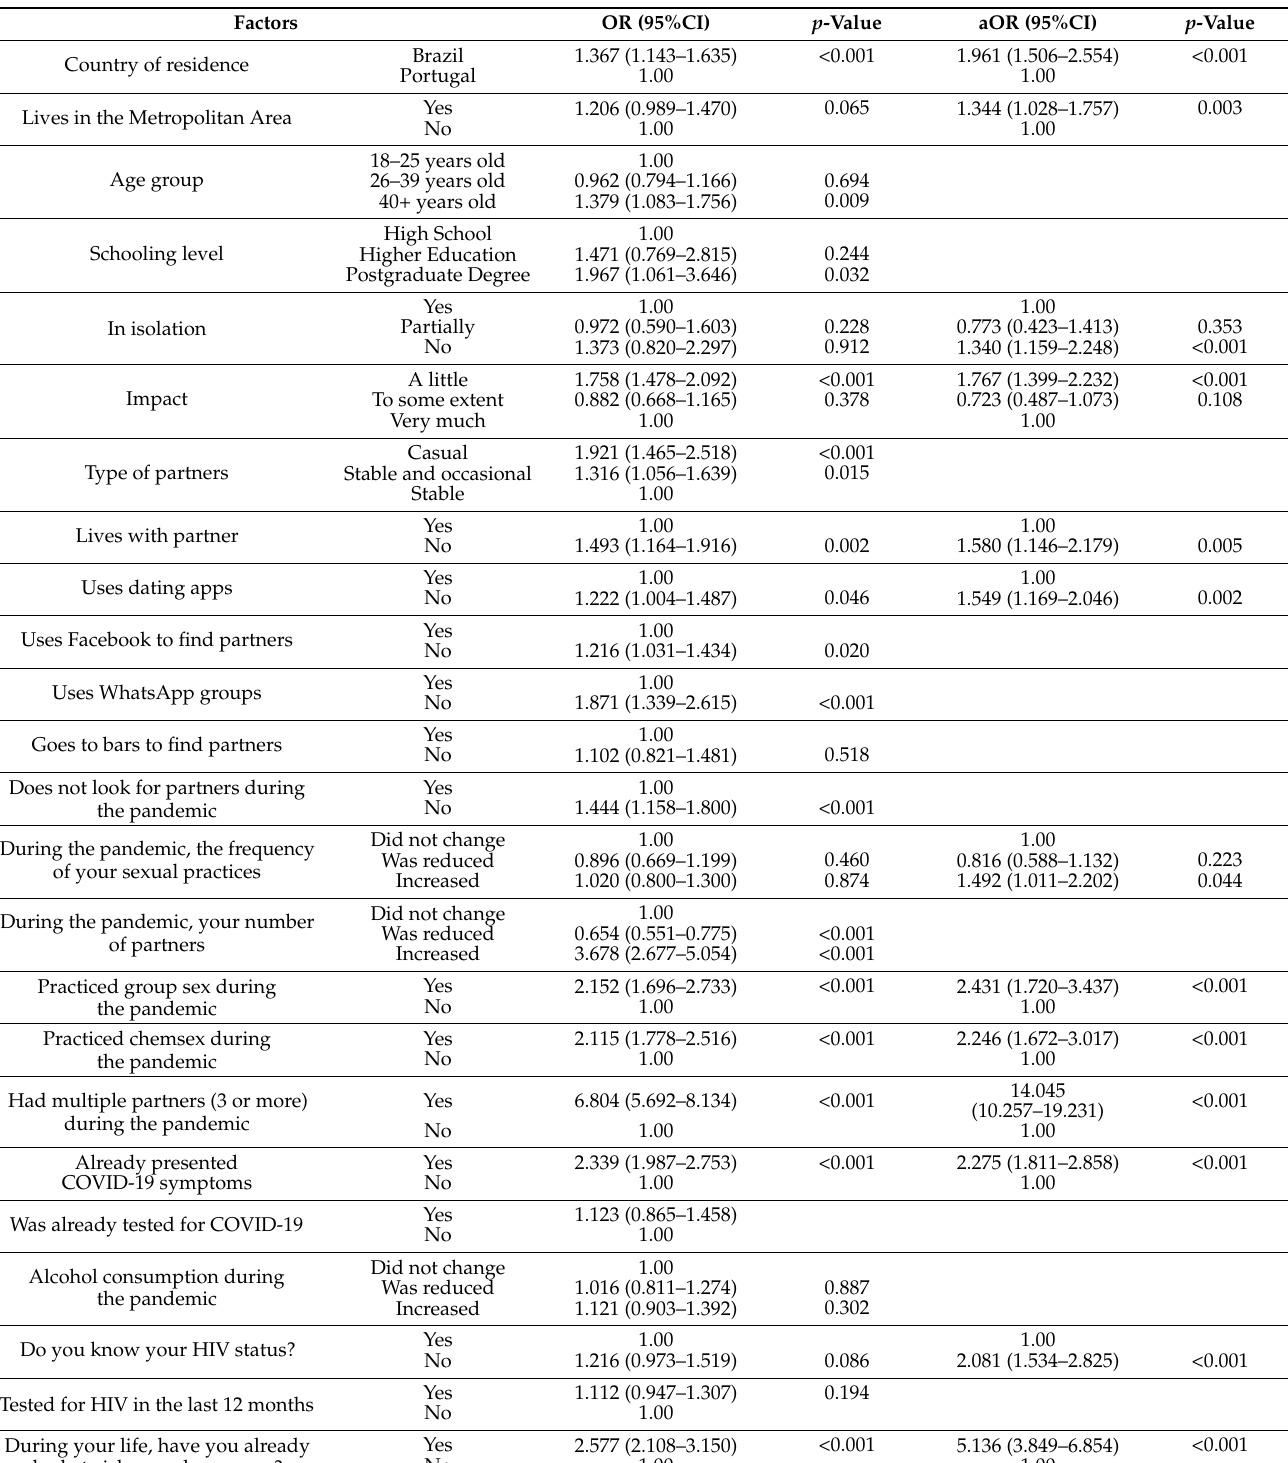
Table 2. Bivariate and multivariate analysis of predictive factors for at-risk sexual exposure during the COVID-19 pandemic, Brazil and Portugal,